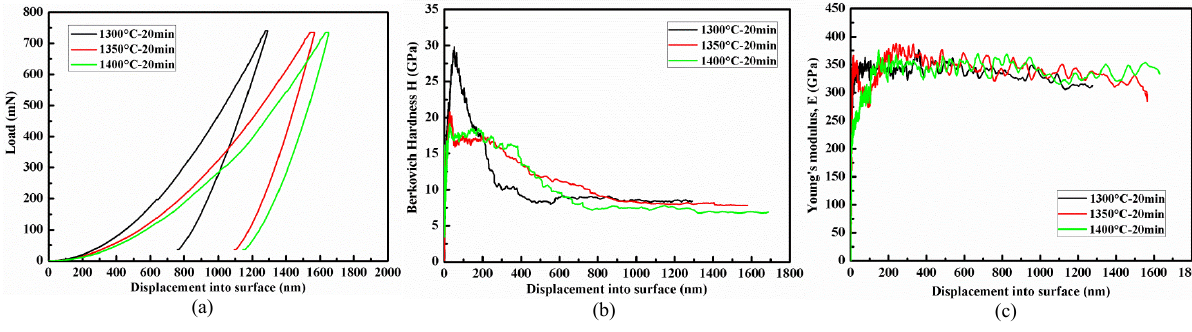
Fig. 14 Variation of (a) load, (b) Berkovich hardness, and (c) Young’s modulus as a function of the displacement into surface for samples sintered at different temperatures for 20